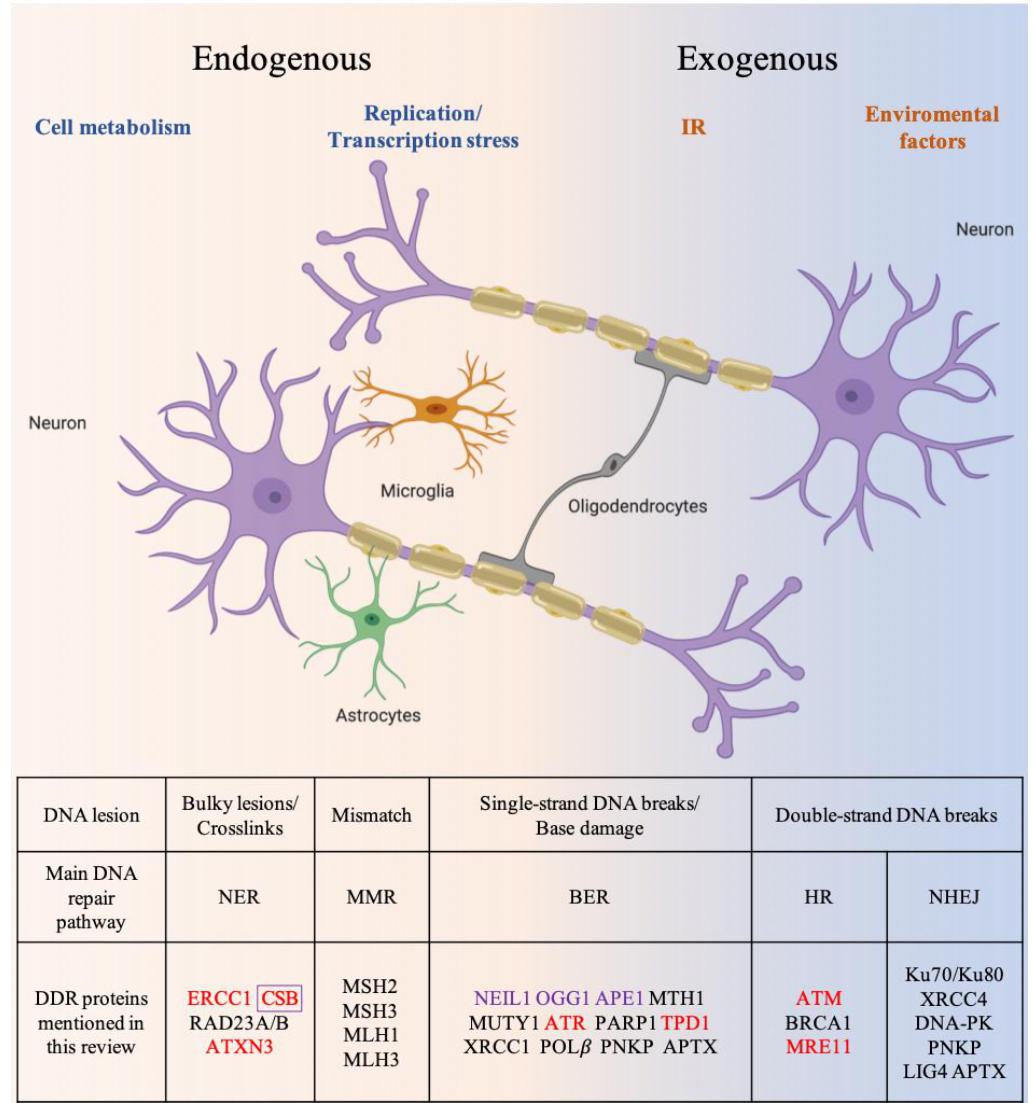
Figure 1. Overview of DNA damage and repair pathways. Classes of endogenous and exogenous DNA damage inducers in neurons and glia cells. Proteins involved in DNA damage response are shown under the heading of the main pathway they act or respond through. For a complete list of mitochondrial and nuclear DNA repair genes, readers are referred to recent comprehensive reviews [21,43]. A selection of proteins known or proposed to contribute to neurodegenerative disease (NDD) pathogenesis is highlighted in red. Selected proteins involved in mitochondrial DNA (mtDNA) damage repair are highlighted in purple. IR: ionizing radiation. Created with BioRender.com.